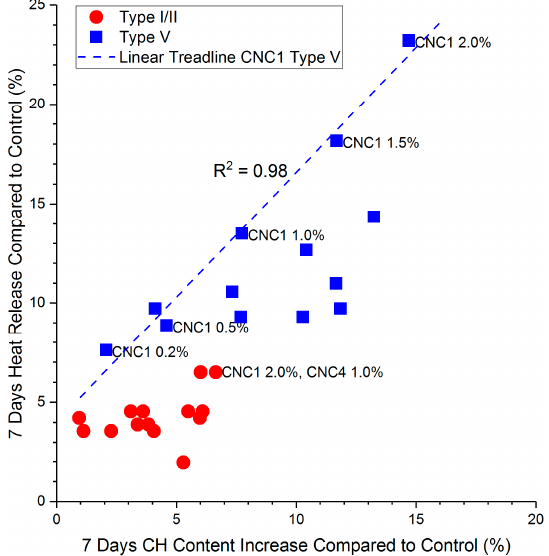
Figure 10. Comparison between the increase in total heat release (%) and the CH content increase (%) at 7 days.